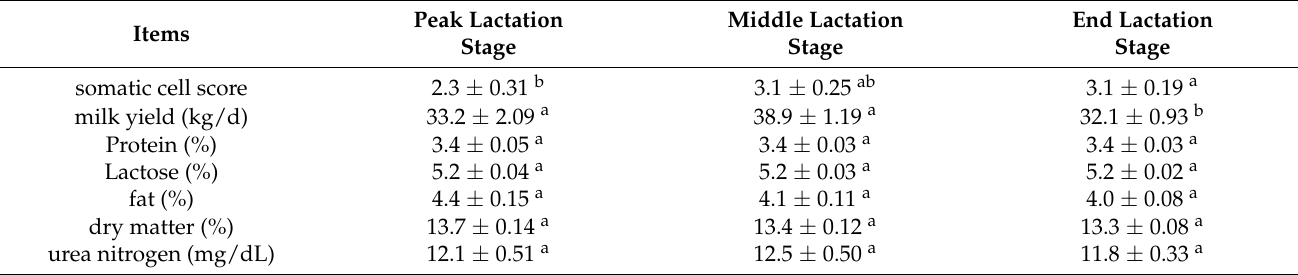
Table 6. The DHI changes of Holstein cows at different lactation stages.